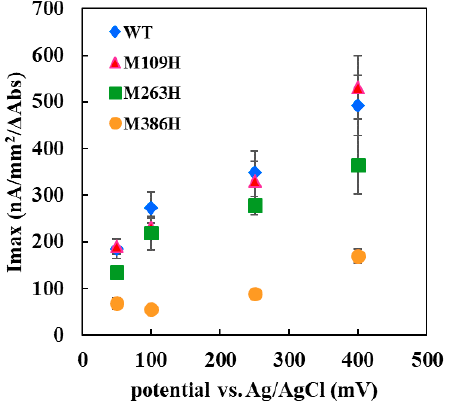
Figure 4. Imax value dependency on the applied potential vs. Ag/AgCl for the electrode immobilized with WT, Met109His, Met263His, or Met386His enzyme.